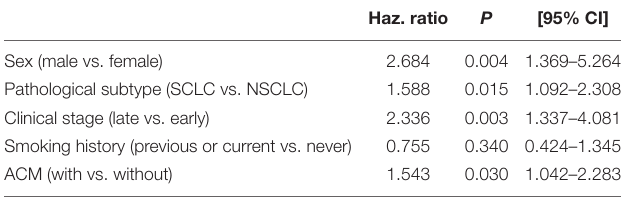
TABLE 7 | Multivariate logistic regression analysis of clinical